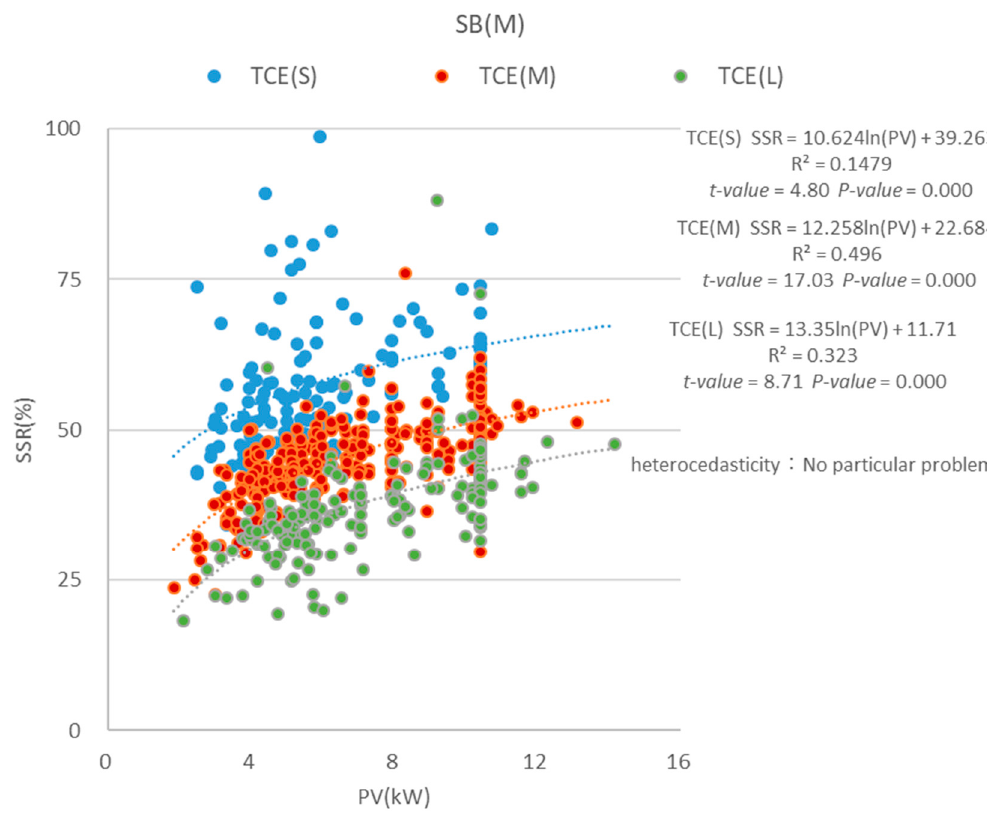
Figure 21. SSR regression equation for each PV capacity by SB (M) GRM and HPWH 100%.